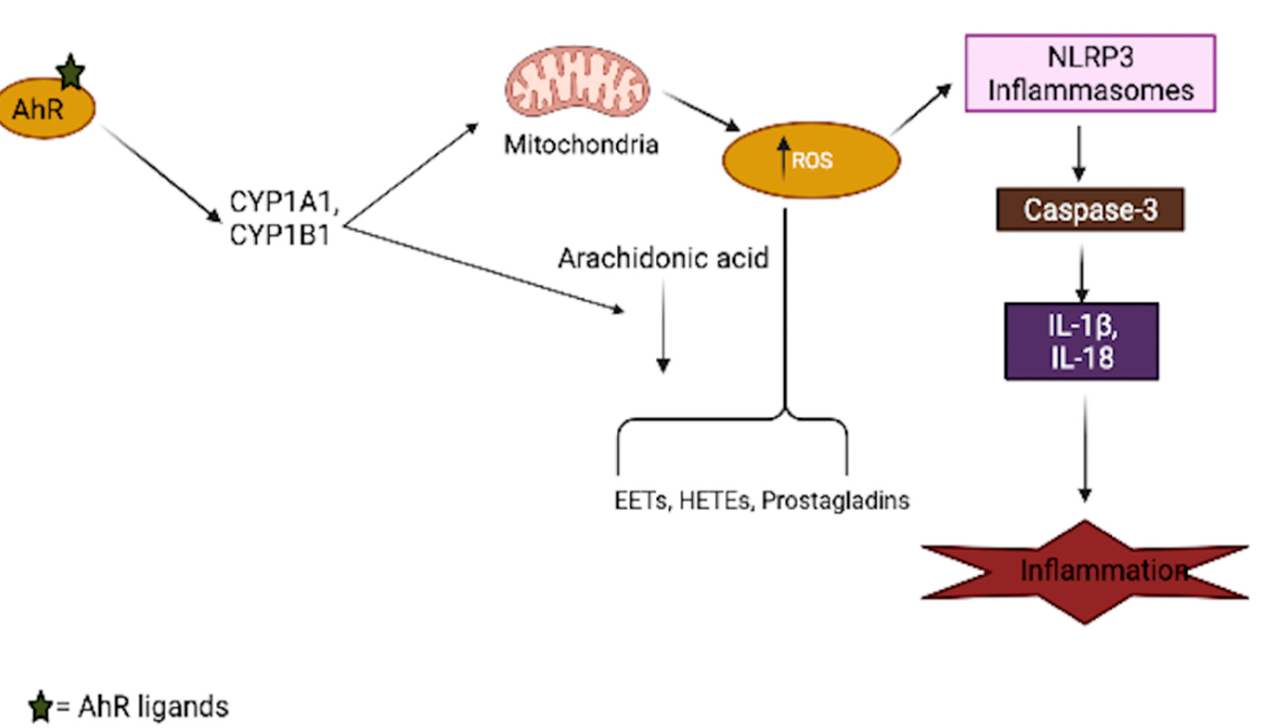
Figure 2. Involvement of AhR in oxidative stress generation. AhR activation by its ligands increases xenobiotic metabolism enzymes (CYPs), which results in mitochondrial toxicity, leading to the generation of reactive oxygen species (ROS). These enzymes also interact with the arachidonic acid pathway and increase the production of several arachidonic acid metabolites, such as EETs (epoxyeicosatrienoic acid), HETEs (hydroxyeicosatrienonic acid) and prostaglandins, which are sources of ROS in several tissues, including the brain. The generation of ROS in turn activates the inflammasome, which aids the secretion of inflammatory cytokines.